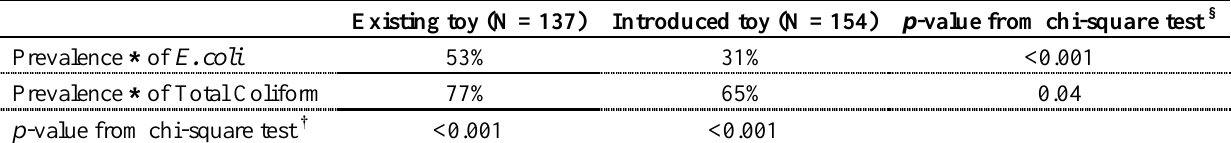
Table 1. Prevalence of bacterial contamination on existing and introduced toys collected from households participating in this pilot study (January 2009) and an RCT of the plastic biosand filter in Copan, Honduras (May 2008–February 2009).